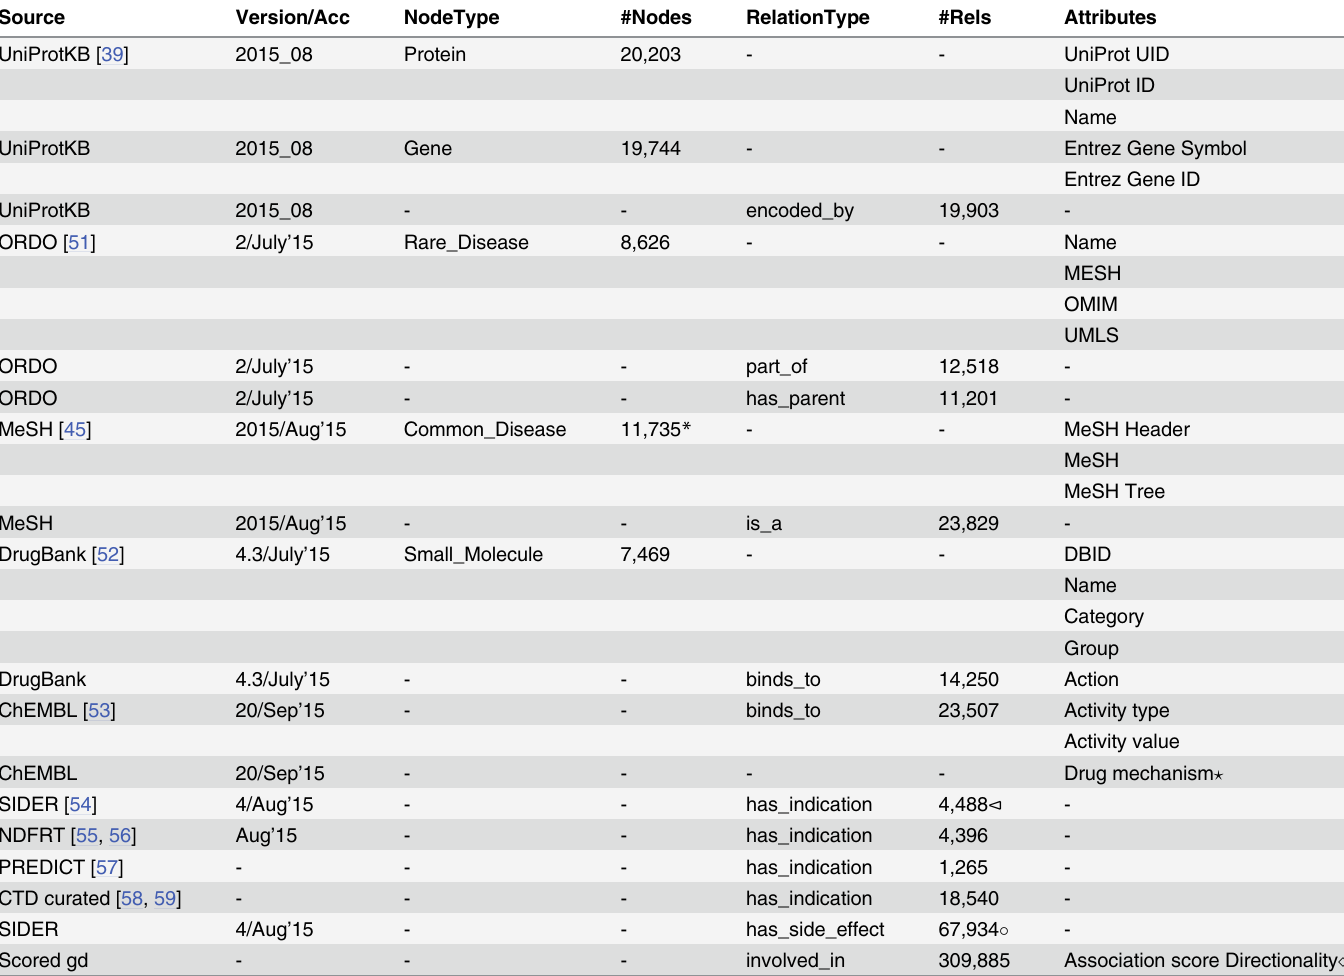
Table 2. Data sources, types, attributes and frequency used in integrated repositioning graph.